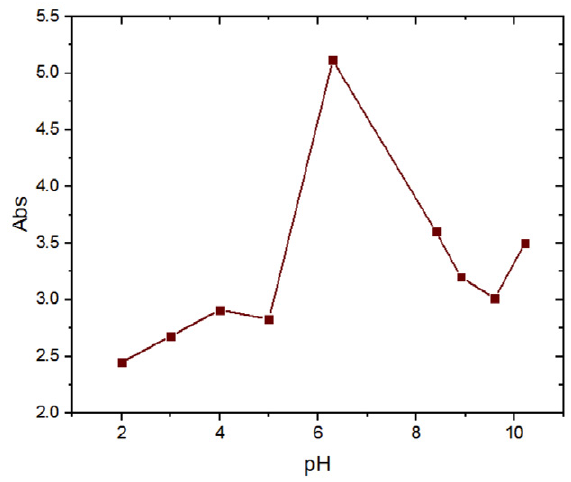
Figure 3. Effect of pH alterations of ( Gr Mn / GO / CS / A. sativum / Que) on drug adsorption